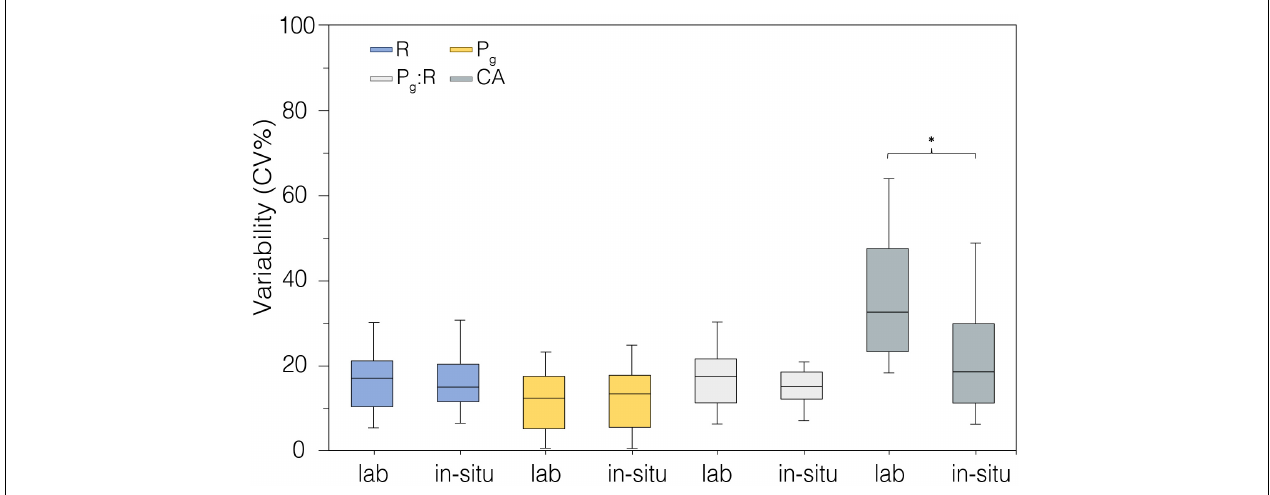
FIGURE 7 | Coefficient of variability (CV%) calculated from metabolic rates measured in laboratory-controlled conditions ( n = 18) and in situ ( n = 18). *indicates statistical difference p <